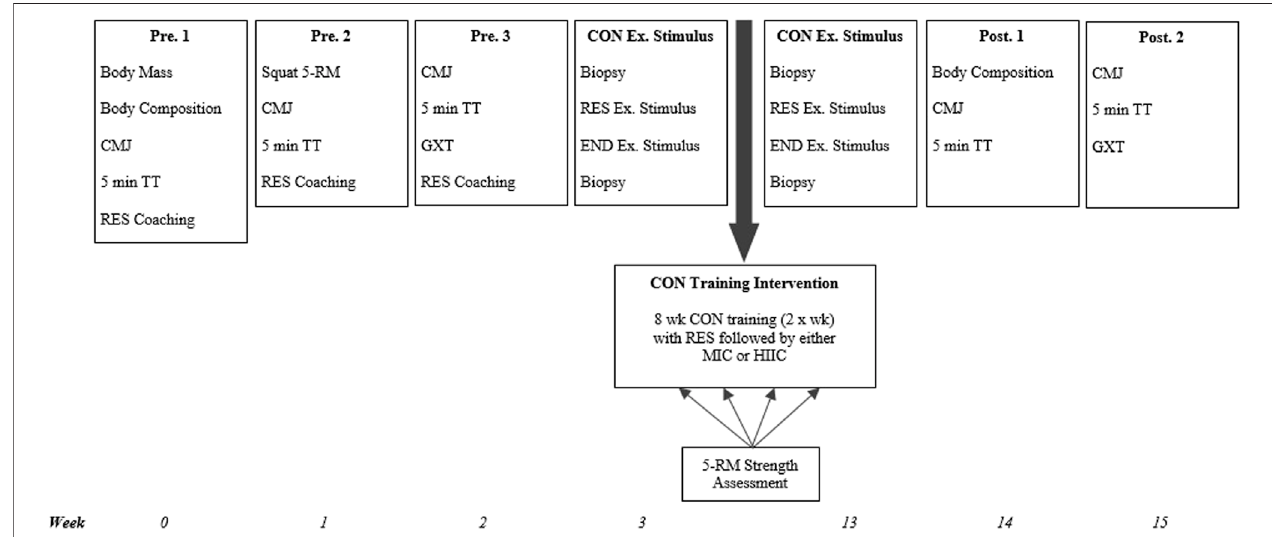
FIGURE 1 | Study schematic. CMJ = counter-movement jump; TT = time trial; RES = resistance exercise; END = endurance exercise; CON = concurrent; Ex. = exercise; wk = week; MICT = moderate intensity cycling; HIIT = high intensity interval training; 5-RM = 5-repitition maximum; GXT = graded exercise test; MICT = moderate intensity cycling; HIIT = high intensity interval cycling.